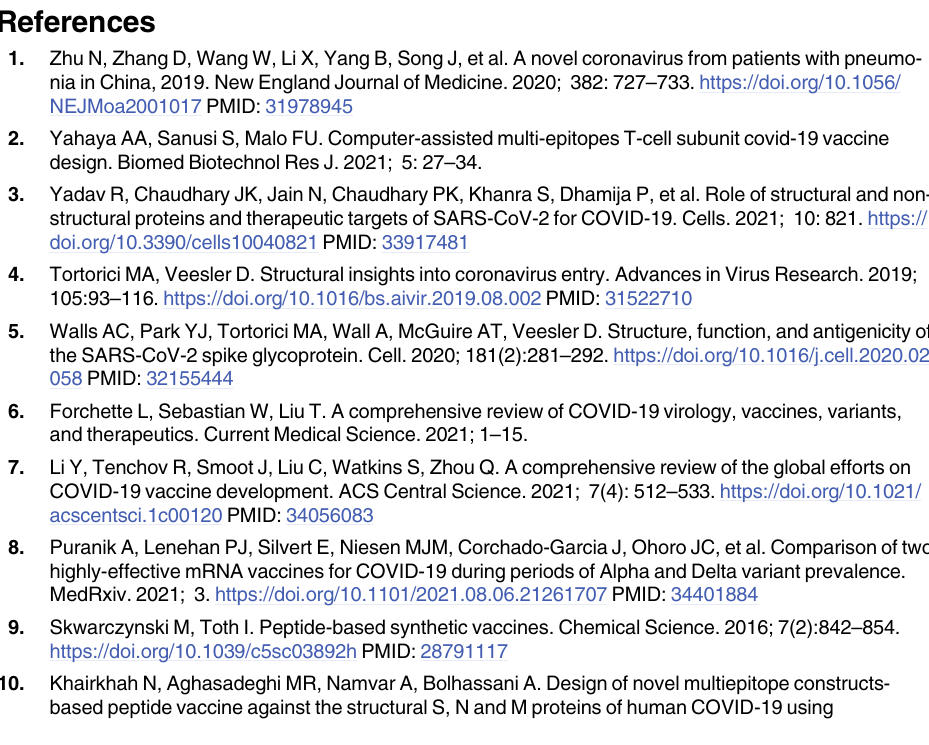
S2 Fig. (RAR) S1 Table. Prediction of linear B-cell epitopes in the designed S-N-M multiepitope peptide.